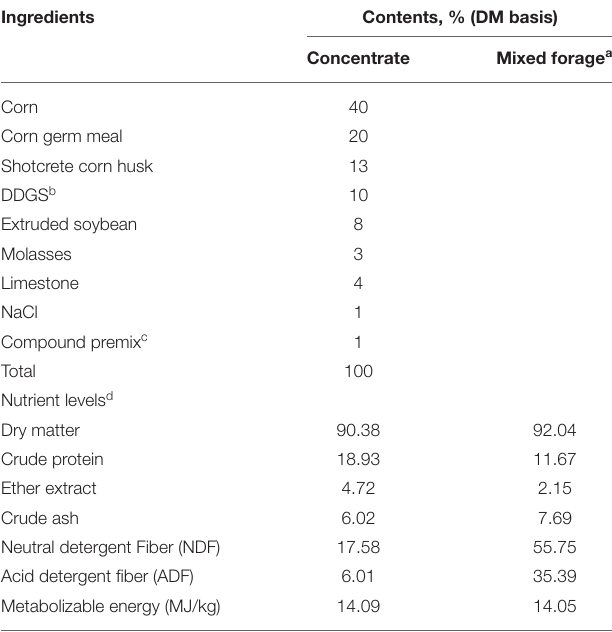
TABLE 1 | Composition and nutrient levels of diets (DM basis,